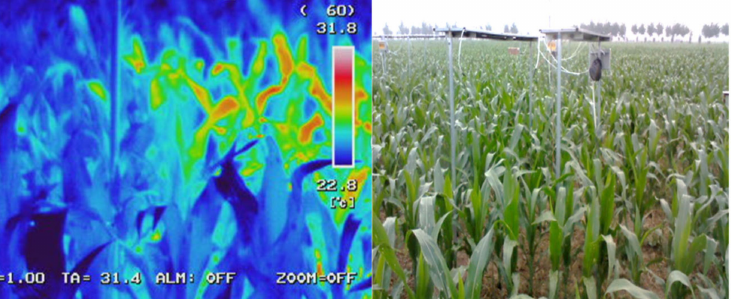
Figure 2. Free air temperature increase systems in the nocturnal warming experiment on maize (photo taken by an infrared camera on 17 July